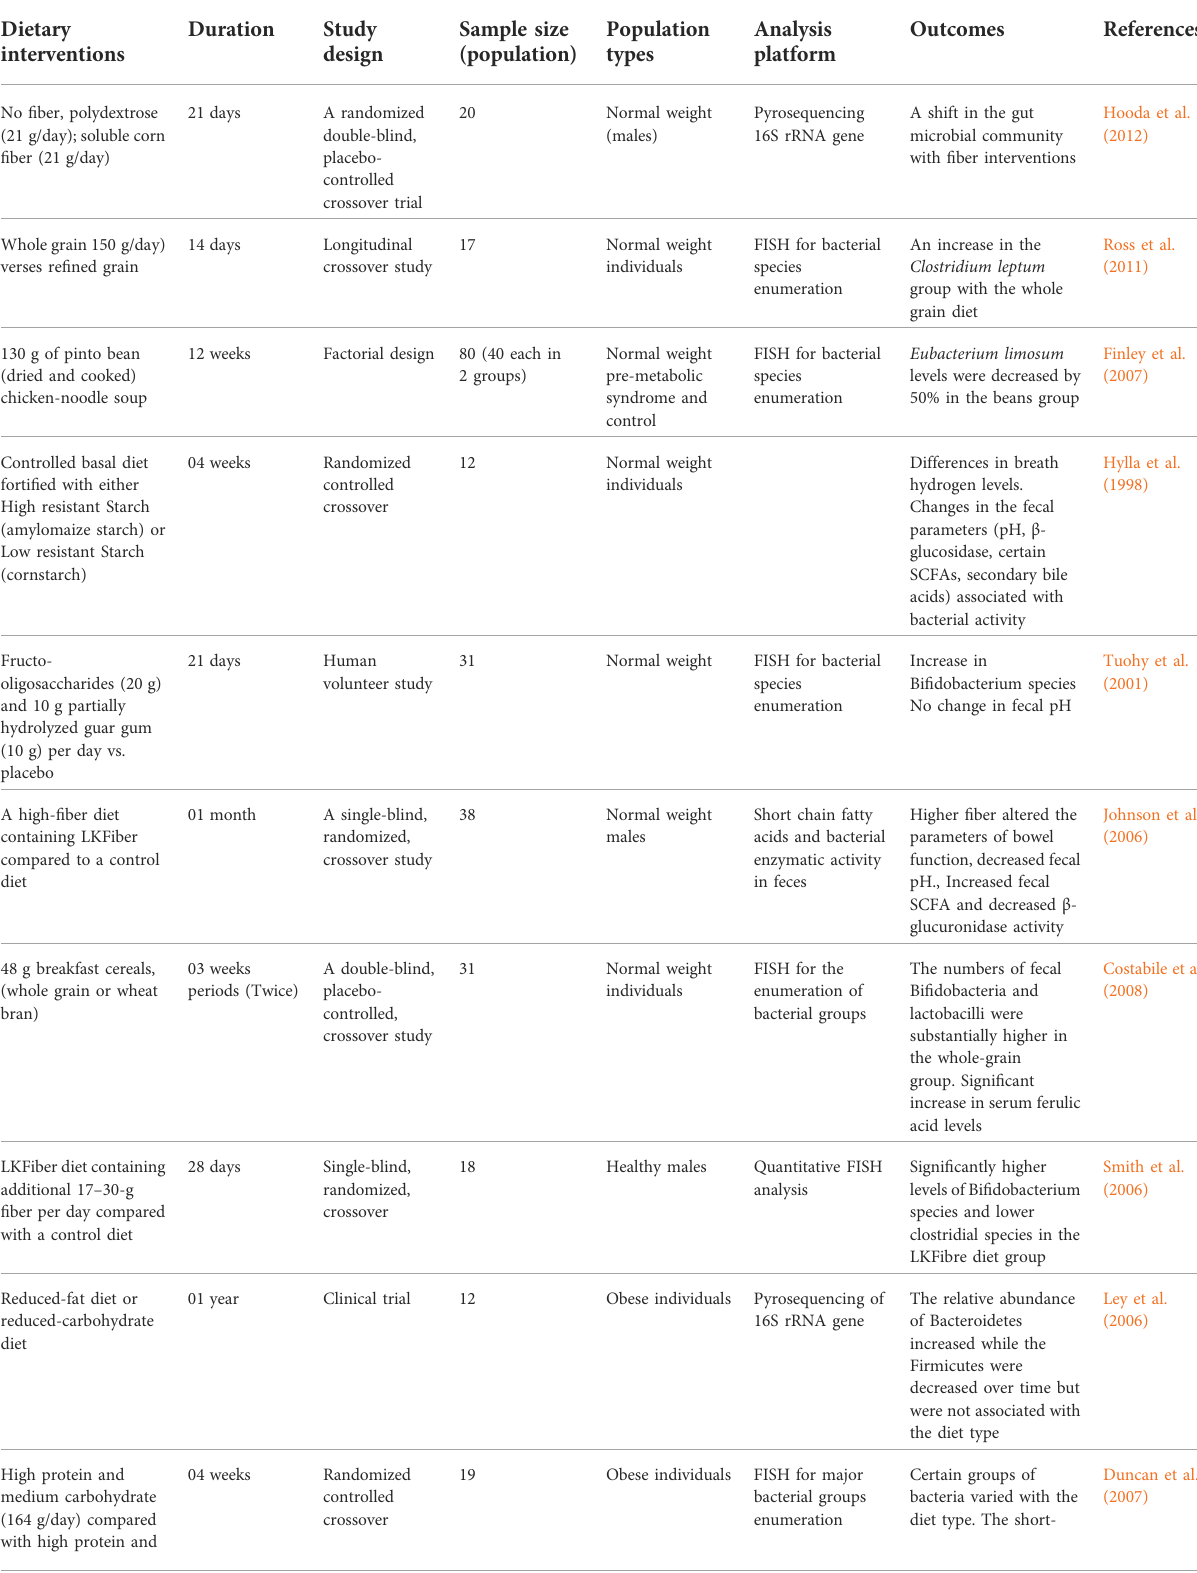
TABLE 1 The response of gut microbiome to the dietary